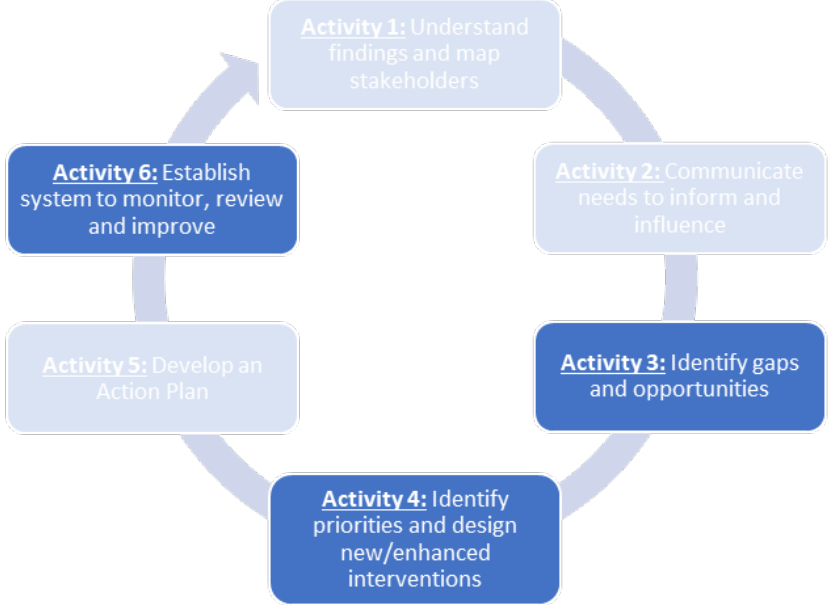
Figure 2. Adapted knowledge to action (KTA) framework.